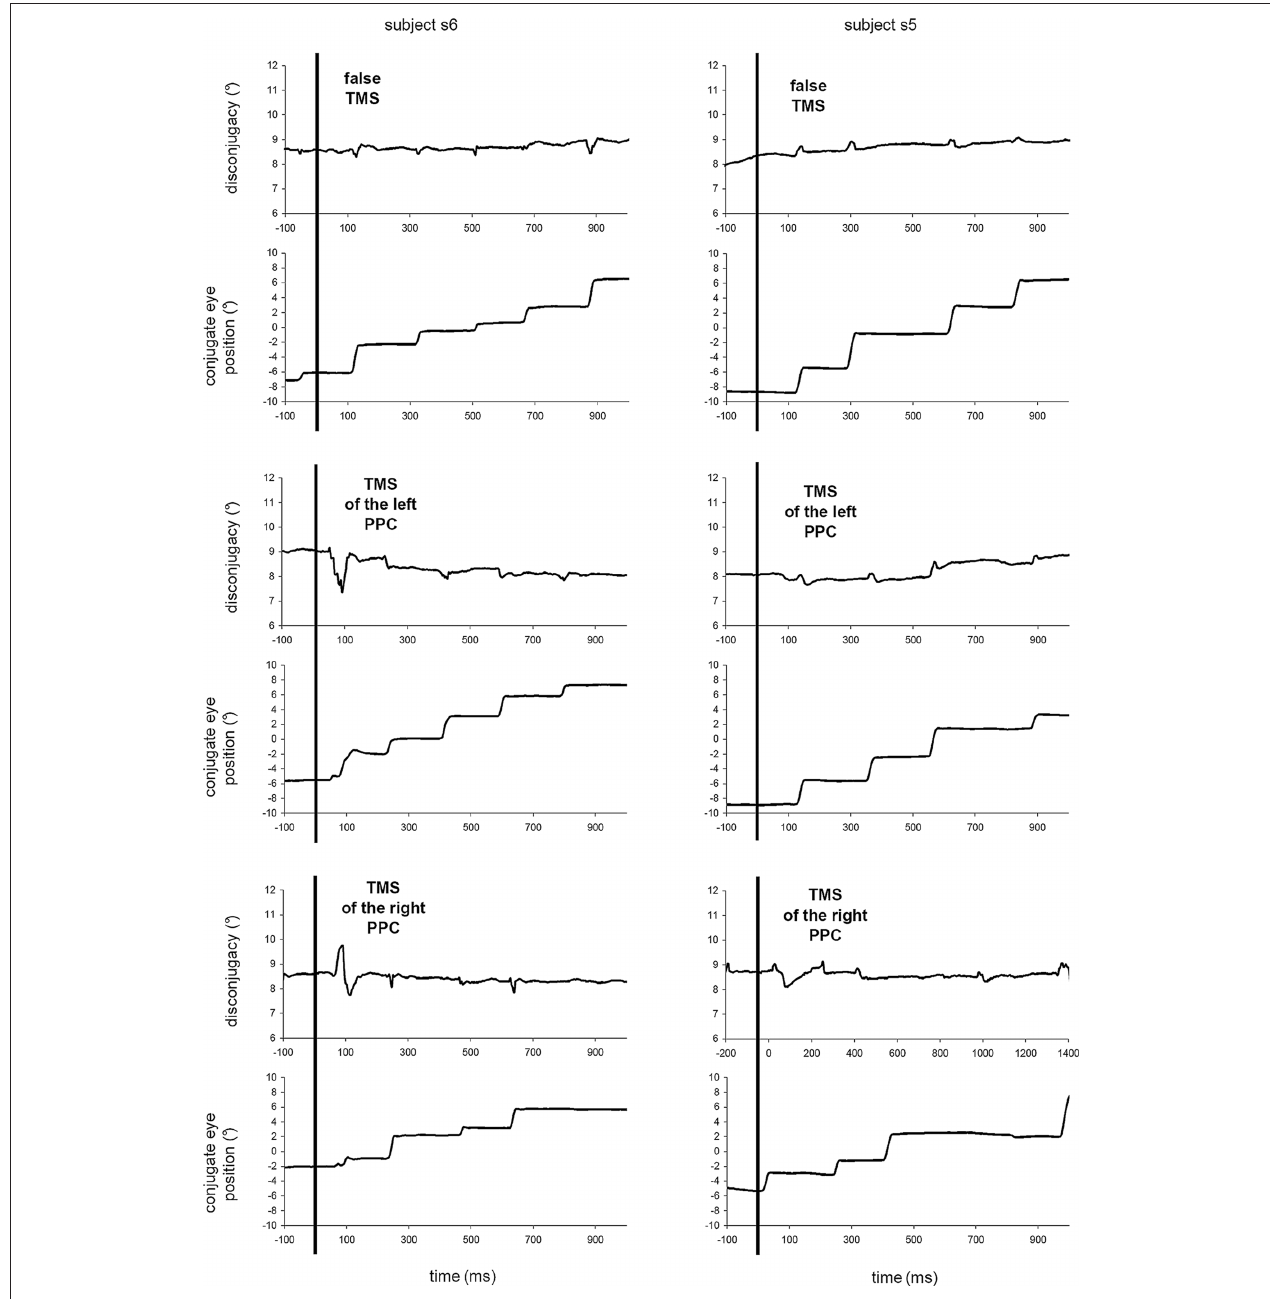
PPC stimulation for the subjects s5 and s6. Vertical lines indicate the occurrence of a stimulation, at t = 0. Examples were chosen to observe several rightward saccades after stimulation, but TMS could occur at any time during the